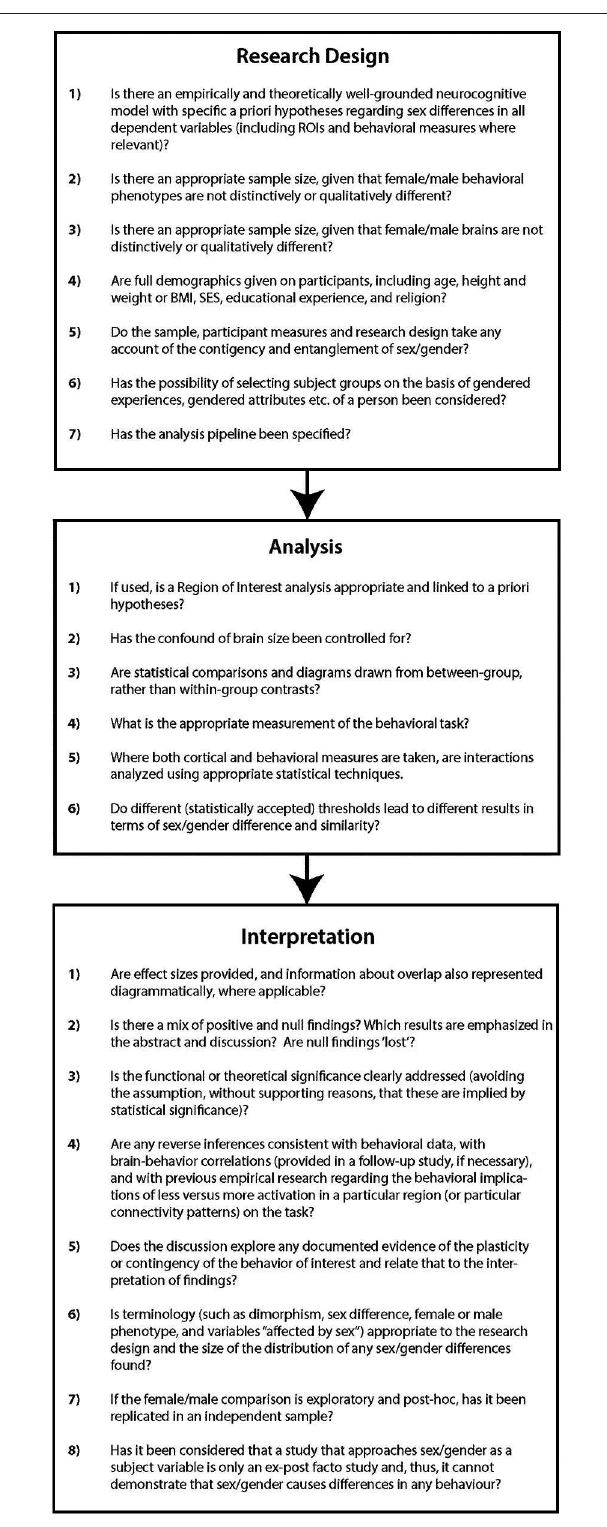
FIGURE 3 | Proposed guidelines for sex/gender research in neuroscience: critical questions for research design, analysis, and interpretation